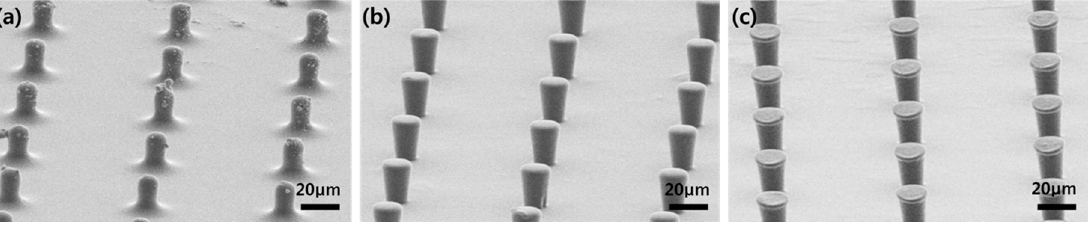
Figure 2. SEM images of mushroom structures fabricated with various pressures: ( a ) 0 kPa, ( b ) 10 kPa, ( c ) 25 kPa.